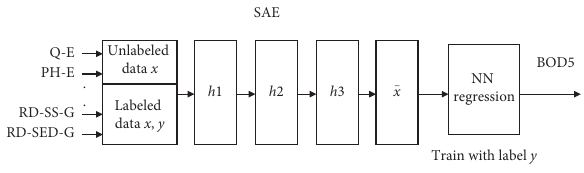
Figure 2: SAE-NN’s BOD5 prediction